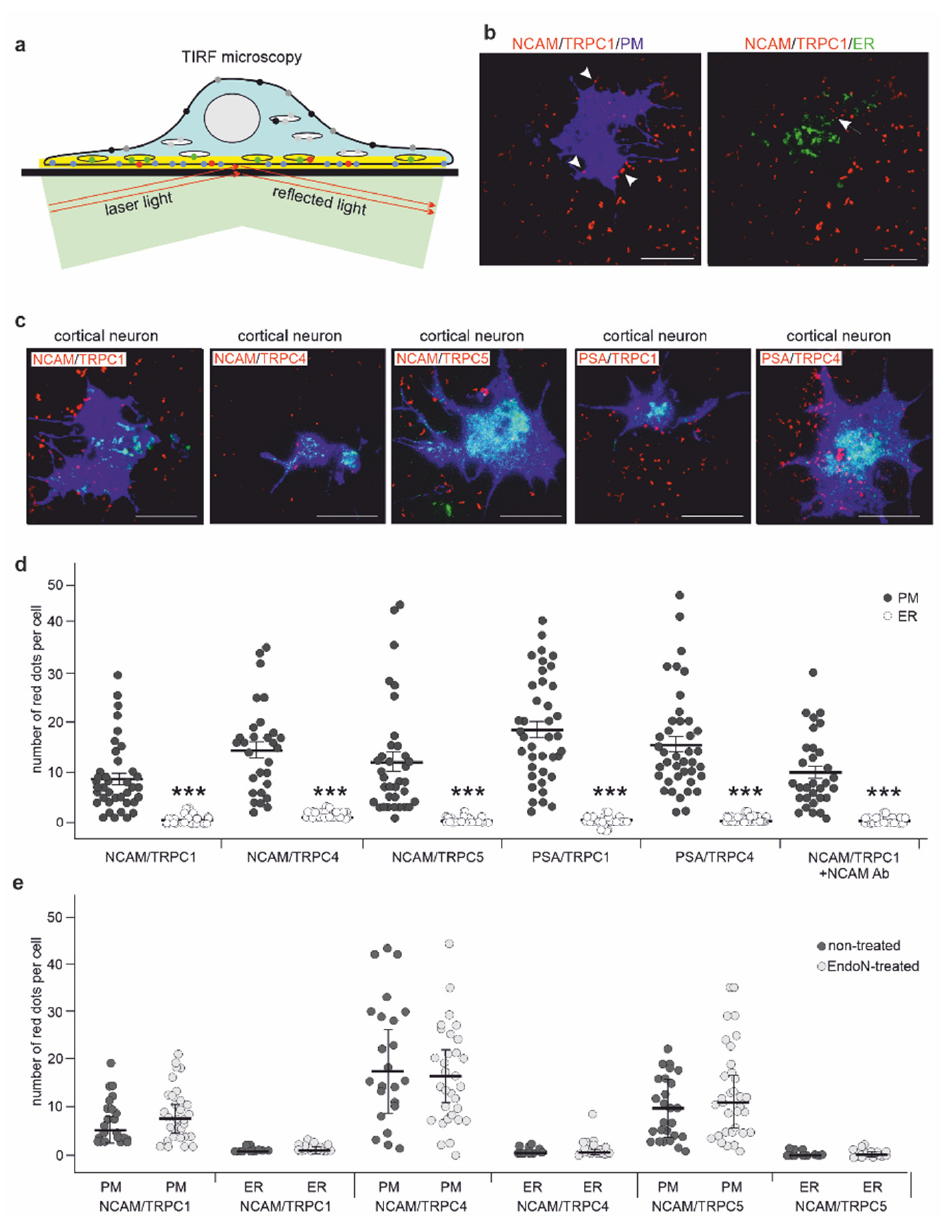
Figure 7. NCAM colocalizes with TRPC1, − 4, and − 5 predominantly in the plasma membrane of cortical neurons. ( a ) The scheme illustrates the principle of TIRF microscopy. A glass coverslip (black bar) and an adhering neuron (light blue) with nucleus and ER (ovals) are depicted. Application of laser light (light green; red arrows) at a certain angle leads to total reflection of light at the interfaces of the glass coverslip and the aqueous film between coverslip and adherent cells, generating an evanescent wave, which creates an evanescent field (yellow area). As the energy in this field decreases exponentially with distance of typically 60–100 nm to the interfaces, only fluorophores in this proximity to the coverslip are excited, leaving other fluorophores in the cell not excited. This allows the detection of protein interactions at the plasma membrane and in the ER membranes near the plasma membrane. Shown within the evanescent field are excited fluorophores indicating TRPC/NCAM interactions (red circles), plasma membrane (PM) marker proteins (blue circles), and ER membrane marker proteins (green circles). Outside of this field, light grey, dark grey, and black circles indicate the corresponding nonexcited fluorophores. ( b – e ) Cultured wild-type cortical neurons were first transfected with plasmids encoding a plasma membrane-associated fusion protein of blue fluorescence protein and the CAAX motif-containing sequence of H-Ras or encoding an ER membrane-associated fusion protein of enhanced green fluo- rescence protein, the ER-targeting sequence of calreticulin, and the ER retention sequence KDEL. Subsequently, the cells were treated without ( d , e ) or with the NCAM antibody ( d ) or EndoN ( e ) and subjected to proximity ligation with rabbit NCAM antibody GTX133217 and mouse TRPC1 antibody E-6, TRPC4 antibody N77/15, or TRPC5 antibody N67/15 or with mouse PSA antibody 735 and rabbit TRPC1 antibody ACC-010 or TRPC4 antibody ACC-018. The neurons were then analyzed by TIRF microscopy. ( b ) Representative images show TRPC1/NCAM interactions (red